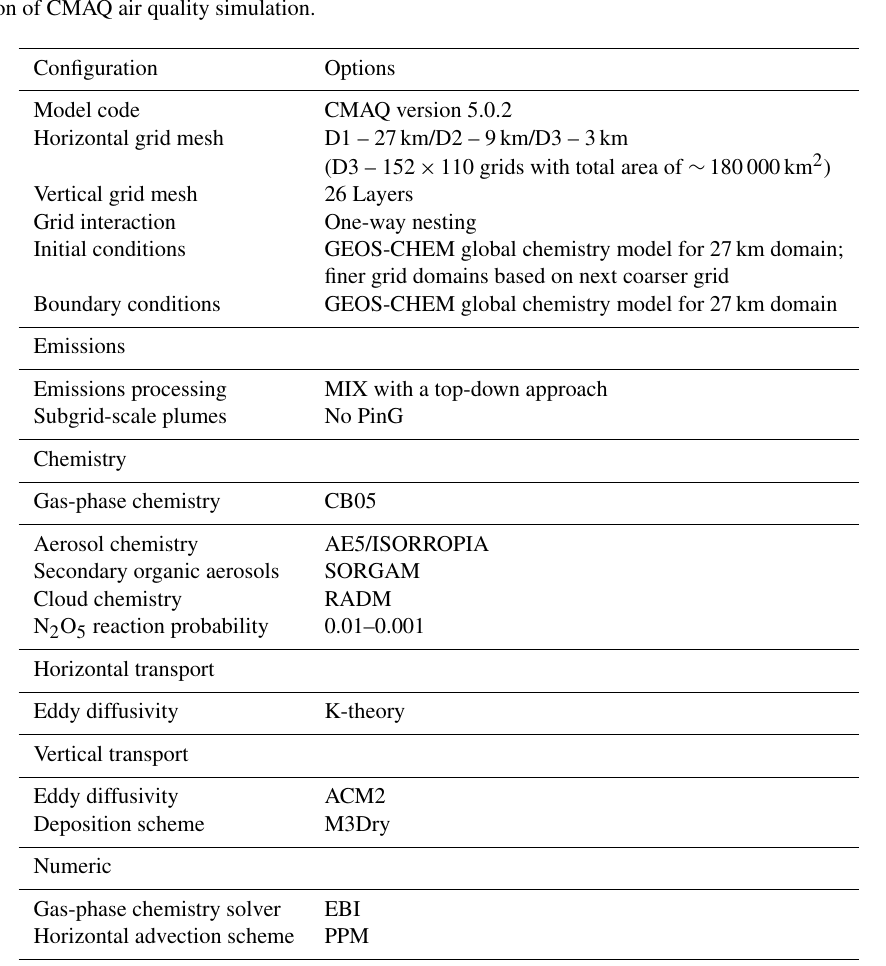
Figure 1. (a) CMAQ simulation domains and (b) D3 domain with observations. Table 1. Configuration of CMAQ air quality